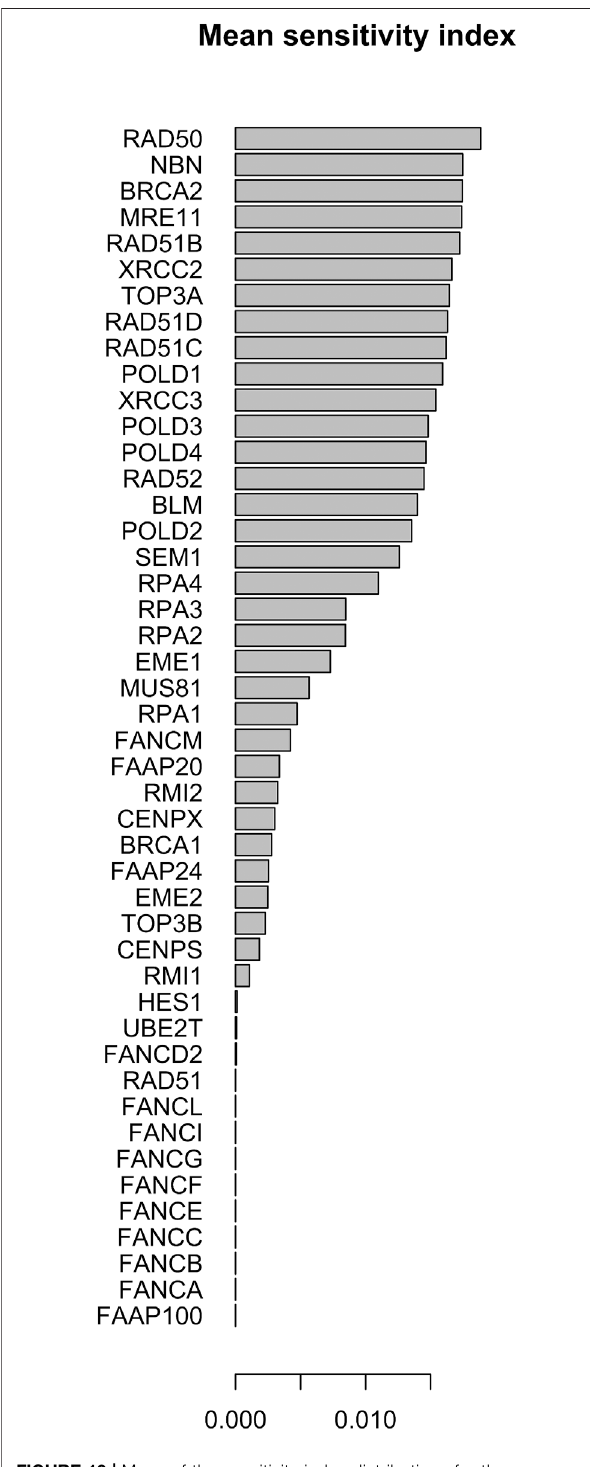
Frontiers in Molecular Biosciences |